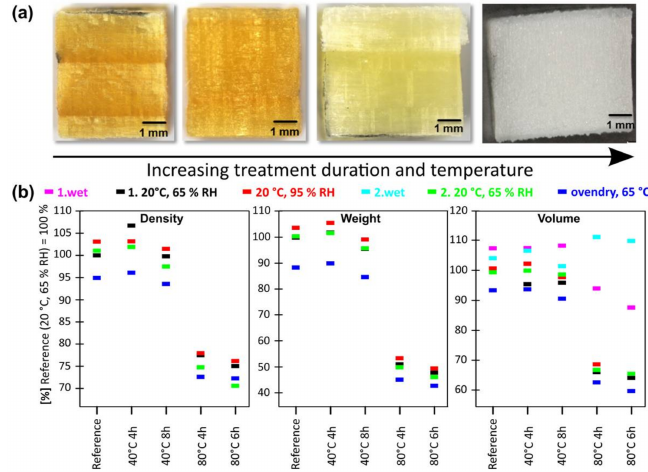
Figure 4. Characterization of acidic bleached spruce wood cubes. ( a ) Light microscopy images of the acidic bleached cubes of spruce wood. ( b ) Relative density variation, weight loss and volume changes for acidic bleached samples treated under different conditions and monitored under the influence of changing climate conditions (colour